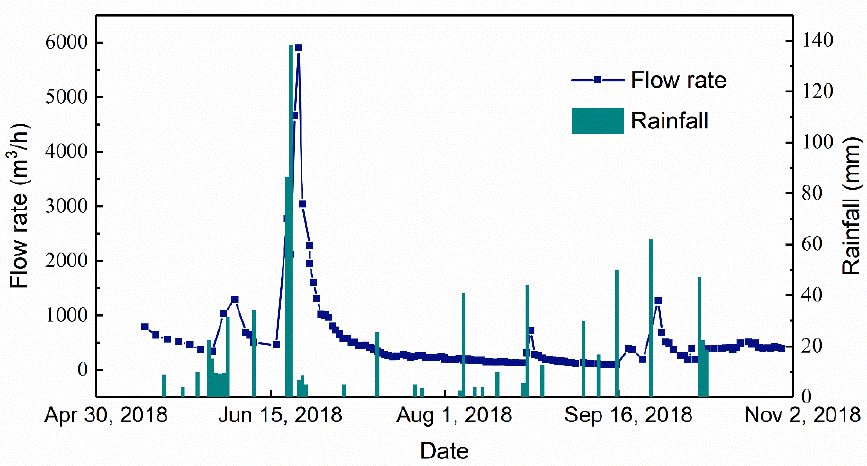
Figure 6. Relationship between spring flow rate and rainfall.